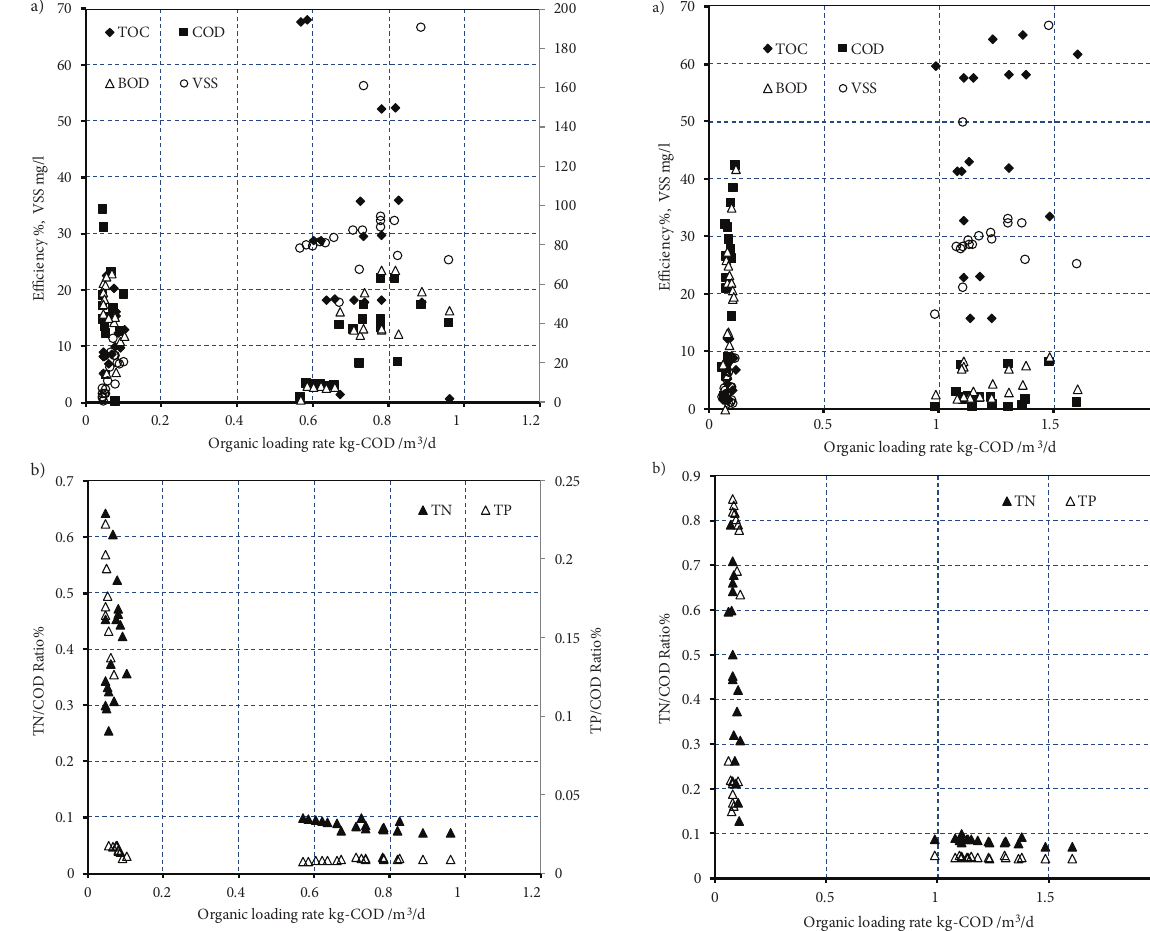
Figure 6. Hybrid biological reactor performance under anaerobic low flow scenario: a) organics removal efficiency and VSS concentration versus organic loading rate; b) TN/COD, TP/COD, versus organic loading rate